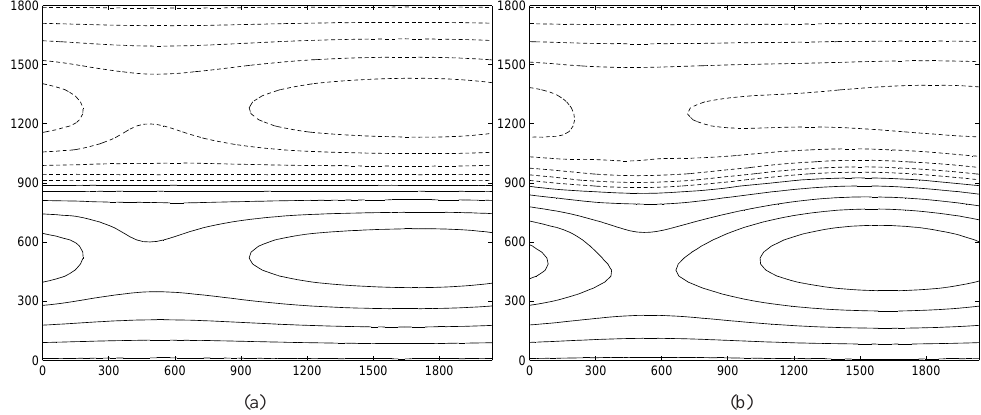
Fig. 6. Atmospheric stream function of two equilibria. (a) Antisymmetric steady state at α = 0 . 12; and (b) asymmetric steady state for the same α -value, both with contours every 0.1 (non-dimensional units).